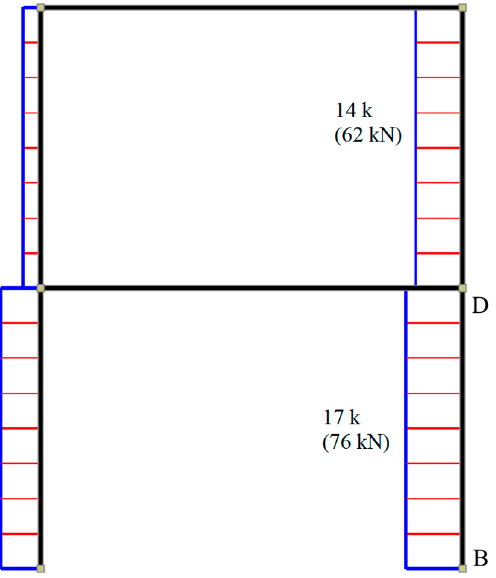
Figure 5. Factored design shear V uc for columns for combined gravity and lateral seismic forces.